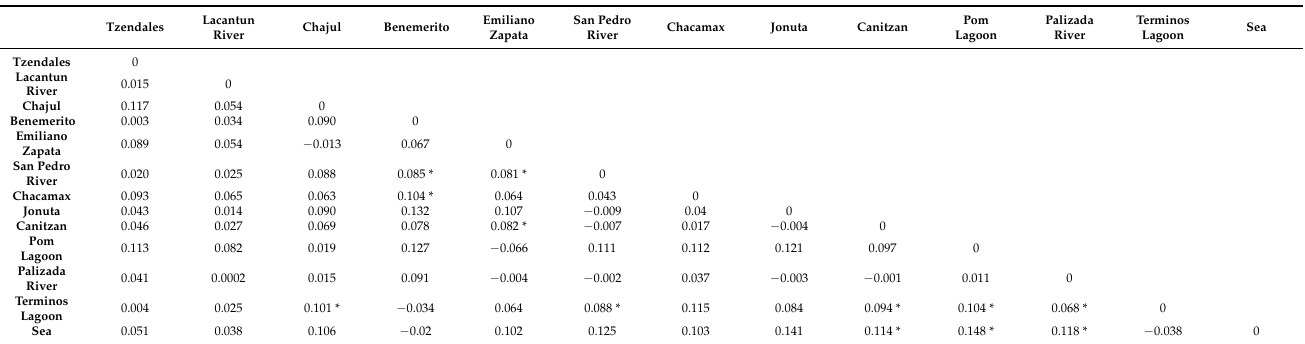
Table 4. Paired F ST values among the 13 sampling localities of Centropomus undecimalis in the Usumacinta basin. Values with the asterisk represent significant values after Bonferroni